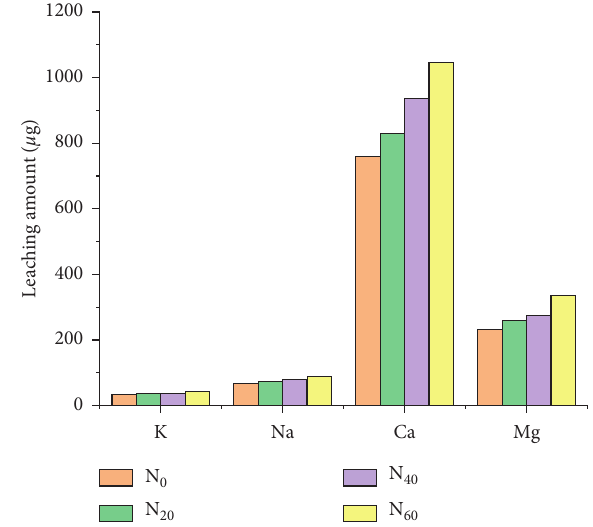
Figure 6: Leaching amounts of base cations under N